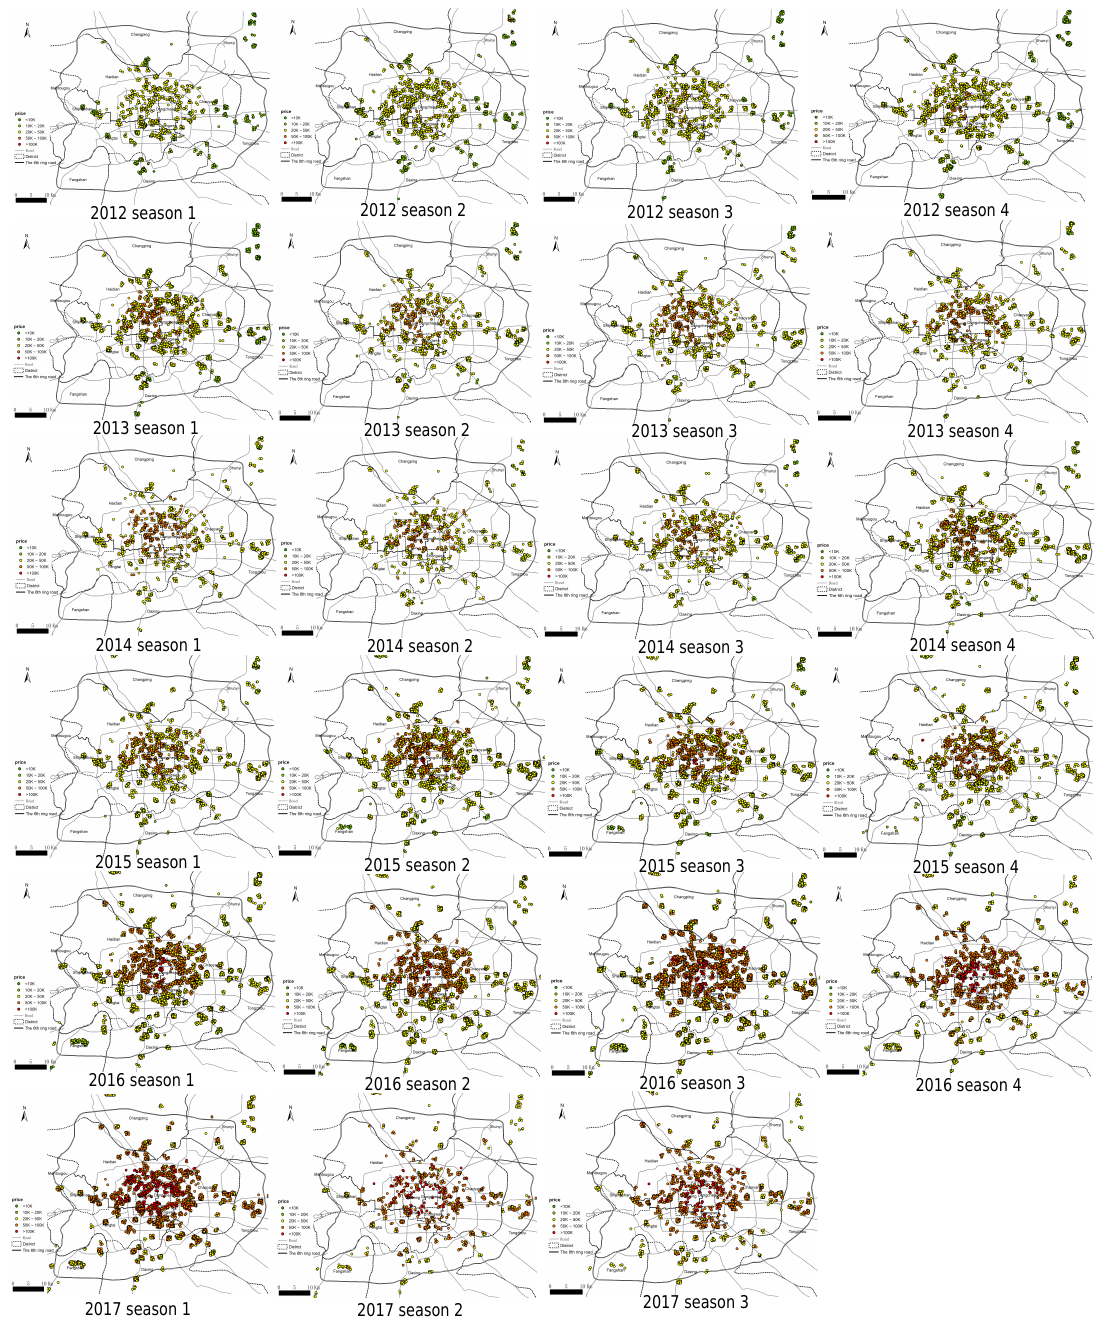
Figure 2. Spatio-temporal distribution of